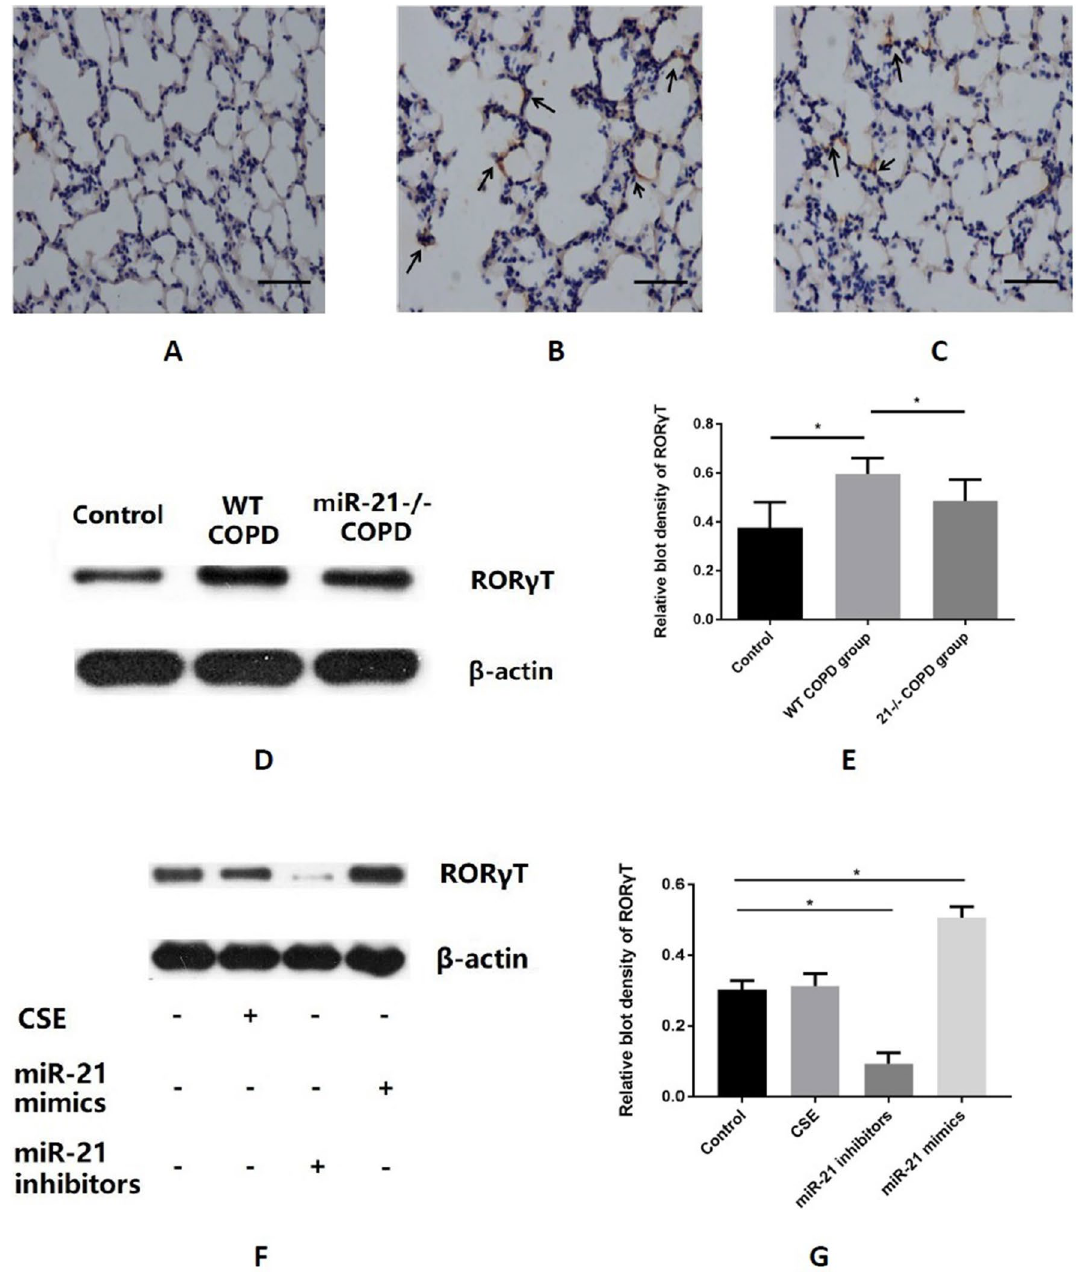
Figure 4. RORγT increased in COPD mice model and could be promoted by either CSE or miR-21. ( A – C ) IHC staining of RORγT in control, modeled-WT or miR-21 −/− mice lungs respectively. Modeled-WT mice have the highest RORγT in lungs while the miR-21 −/− mice are moderate but more than the control. ( D ) The western blot of RORγT in control, modeled-WT or miR-21 −/− mice lungs respectively. ( E ) The quantification of RORγT western blot density in different group. The, modeled-WT mice have the highest RORγT in lungs while the miR-21 −/− mice are moderate but more than the control. ( F ) The western blot of RORγT in control, CSE, miR- 21 mimics or miR-21 inhibitors treated MACS-sorted CD4 + cells. ( G ) The quantification of RORγT western blot density in MACS-sorted CD4 + cells under different treatments. The CSE and miR-21 could both give rise the level of RORγT, meanwhile the miR-21 inhibitors work reversely. In western blot, different samples of the same marker are from the same blot. The data are expressed as the mean ± SEM (n = 5 in each group), t-test and ANOVA test were applied in this part, *P <